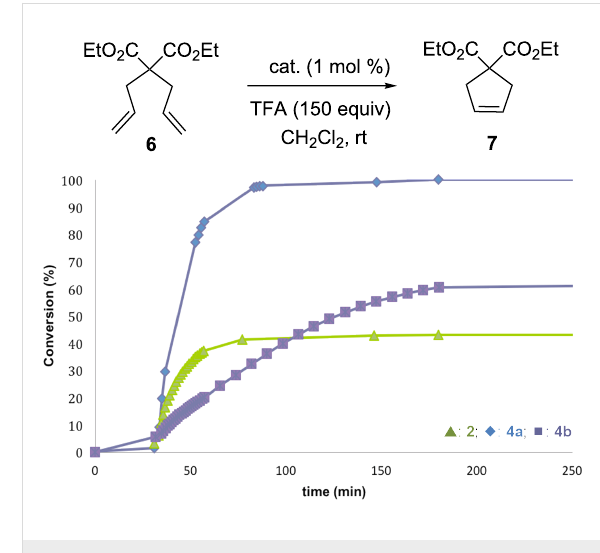
Figure 3: Comparison of olefin metathesis profiles for catalysts 2 , 4a and 4b after activation with 150 equiv of